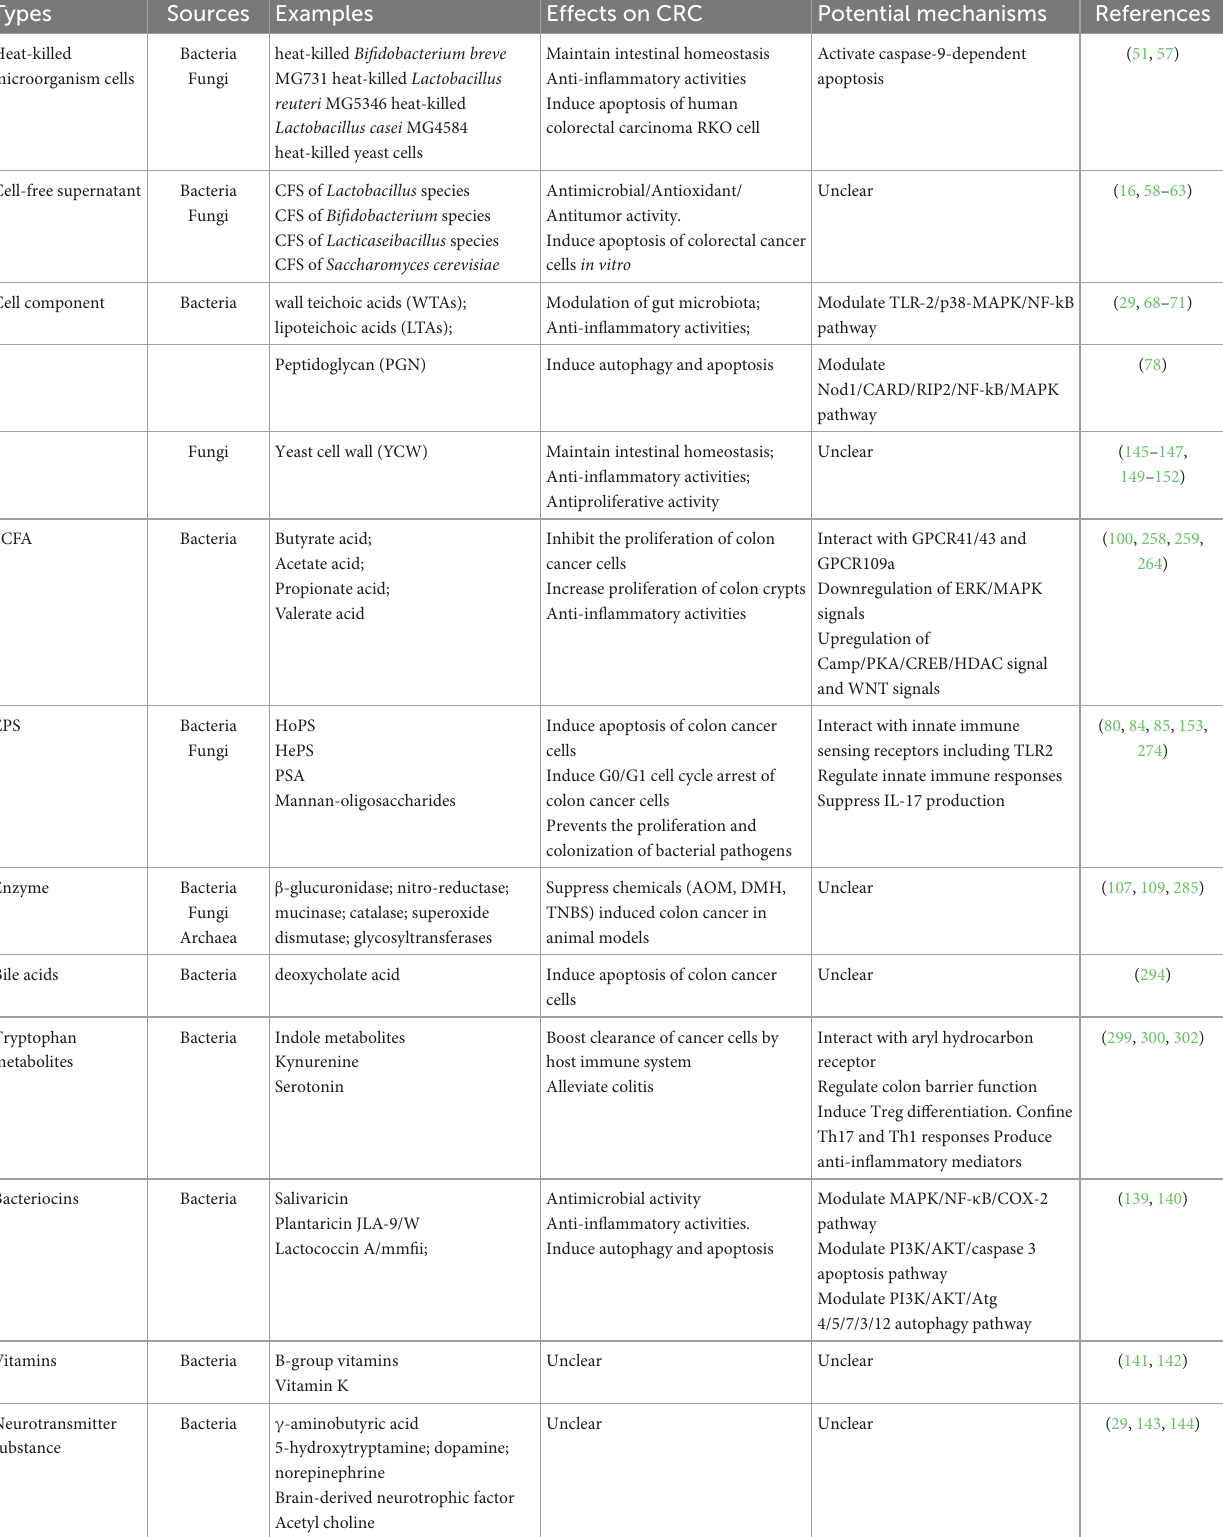
TABLE 1 List of identified postbiotics and beneficial effects for colorectal cancer (CRC)